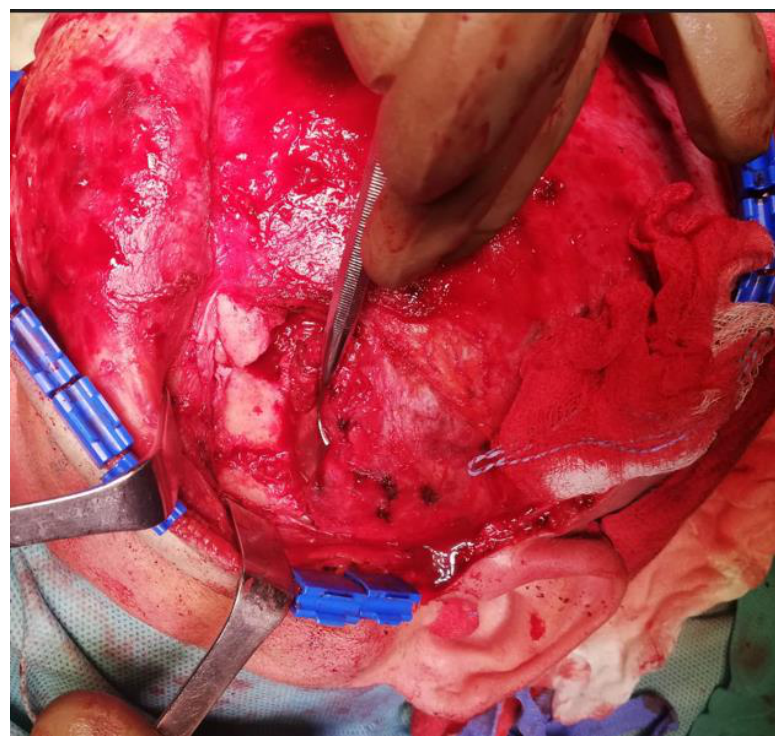
Figure 11. Intraoral view of the displaced zygomatic bone, arch, and lateral eye wall sockets.